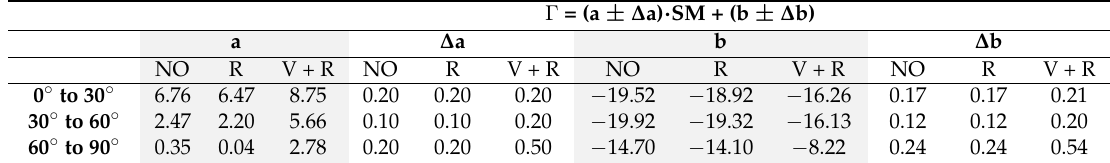
Table 2. Reflectivity fit with respect to range of incidence angles for different corrections: NO: no vegetation correction, no surface roughness correction; R: no vegetation (VOD, ω ) correction, surface roughness correction applied; and V + R: vegetation (VOD, ω = 0) and surface roughness corrections